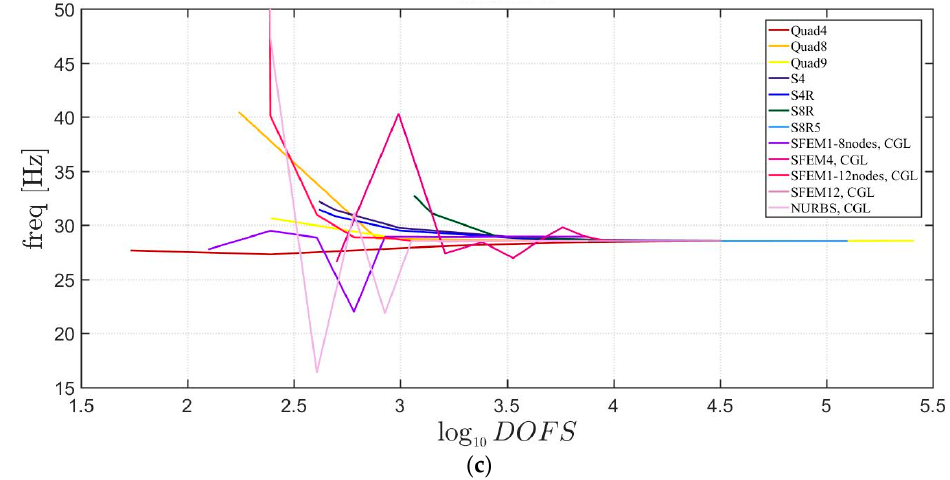
Figure 9. First three natural frequencies of an isotropic elliptic plate with b / a = 2.5: ( a ) First frequency; ( b ) Second frequency; ( c ) Third frequency.